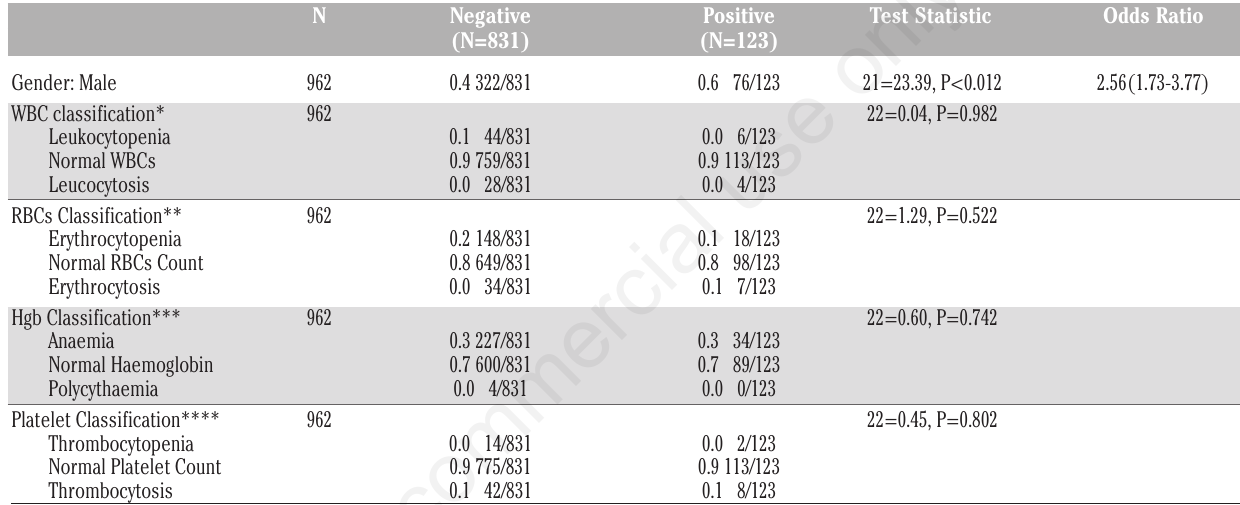
Table 2. Cross table for the association between gender, WBCs, RBCs and Platelets categories and test result. N Negative Positive